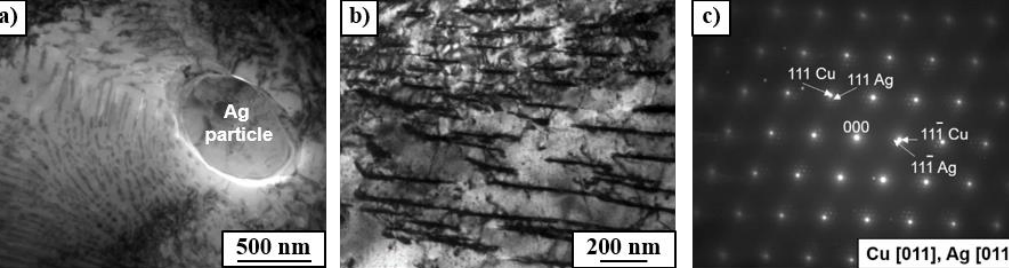
Figure 3. ( a , b ) Bright field TEM images of the Cu–8wt.%Ag alloy after annealing at 400 °C and ( c ) SAED pattern taken from image ( b ).